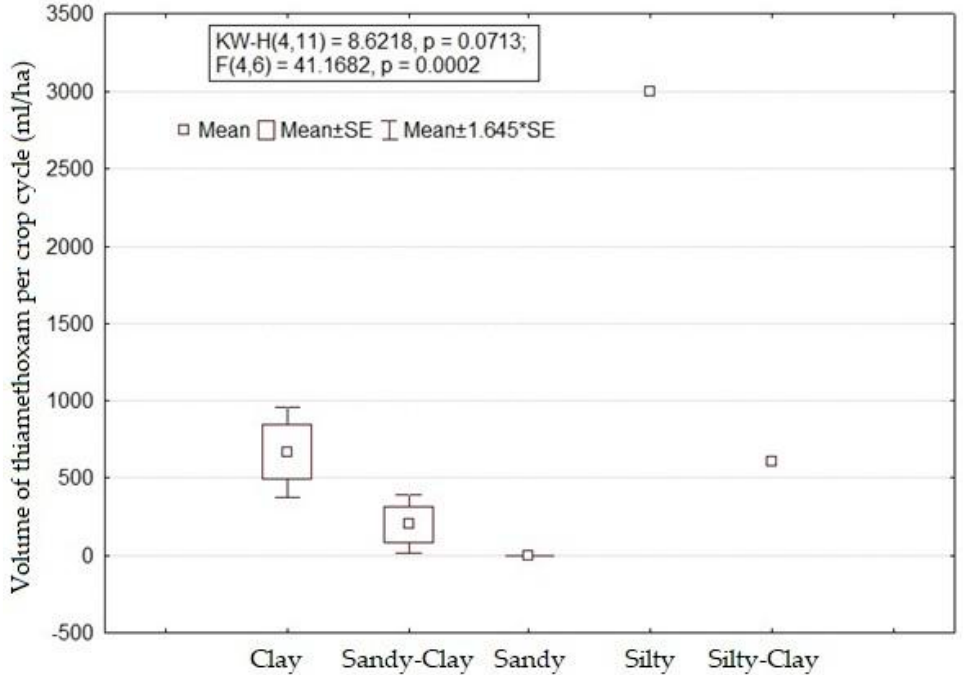
Figure 8. Volume of thiamethoxam per crop cycle managed in different types of soil in the municipality of Cotaxtla, Veracruz.